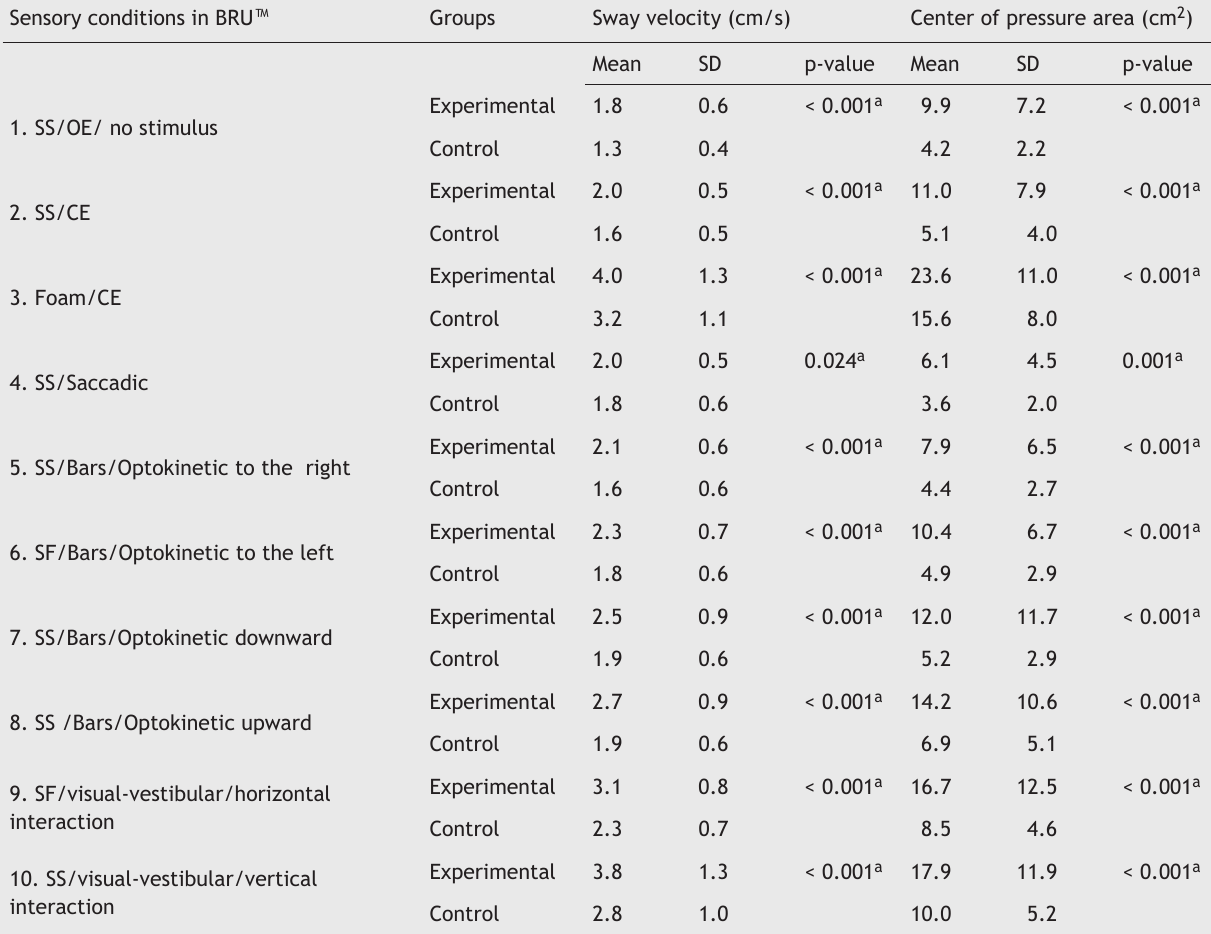
Table 1 Mean, standard deviation, and p-values of sway velocity (cm/s) and center of pressure area (cm 2 ) in the experimental group of underachieving students and control group (students with good academic performance) in the ten conditions of static Balance Rehabilitation Unit (BRU ™